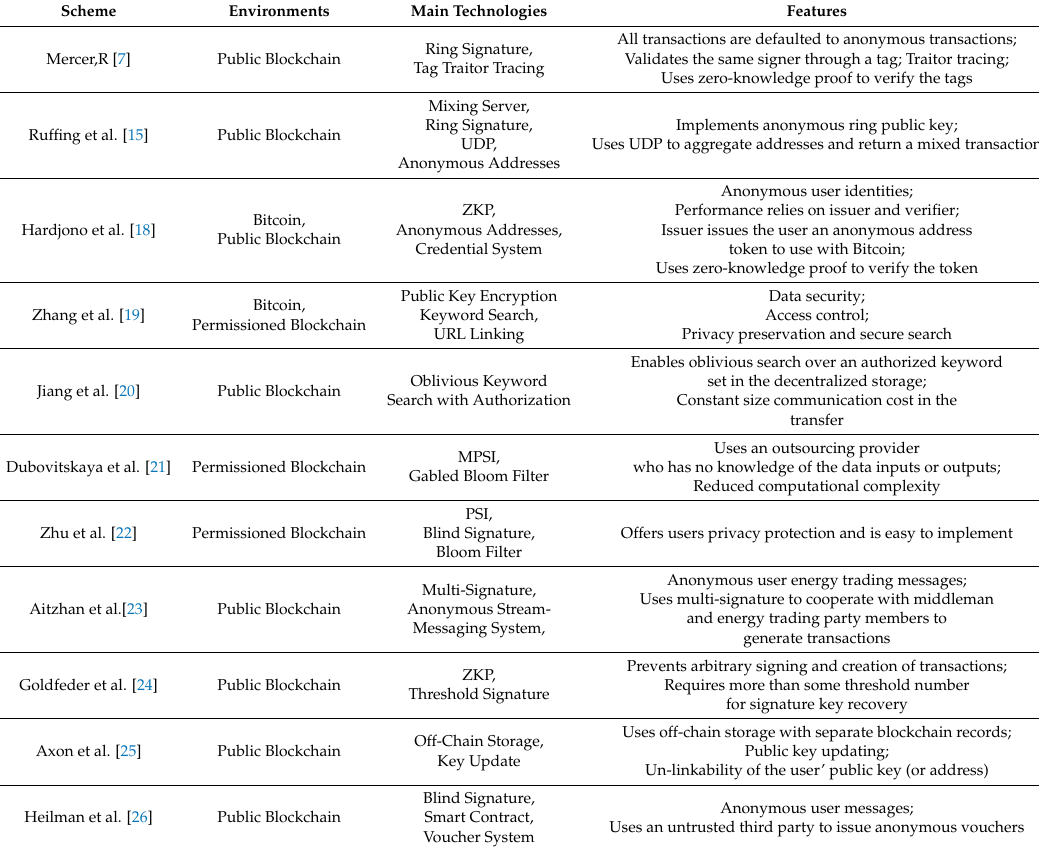
Table 1. List of privacy features by scheme for